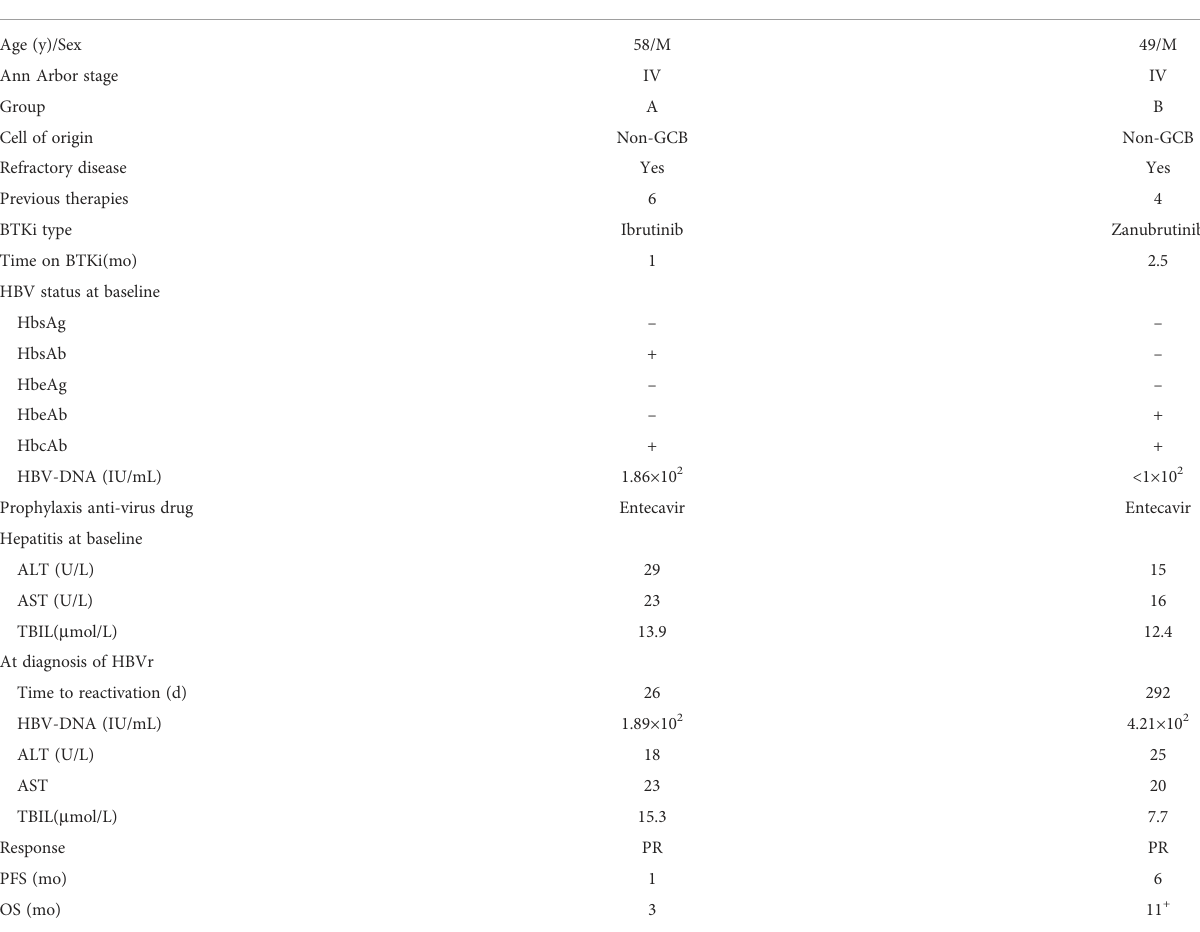
TABLE 2 Details of 2 patients with